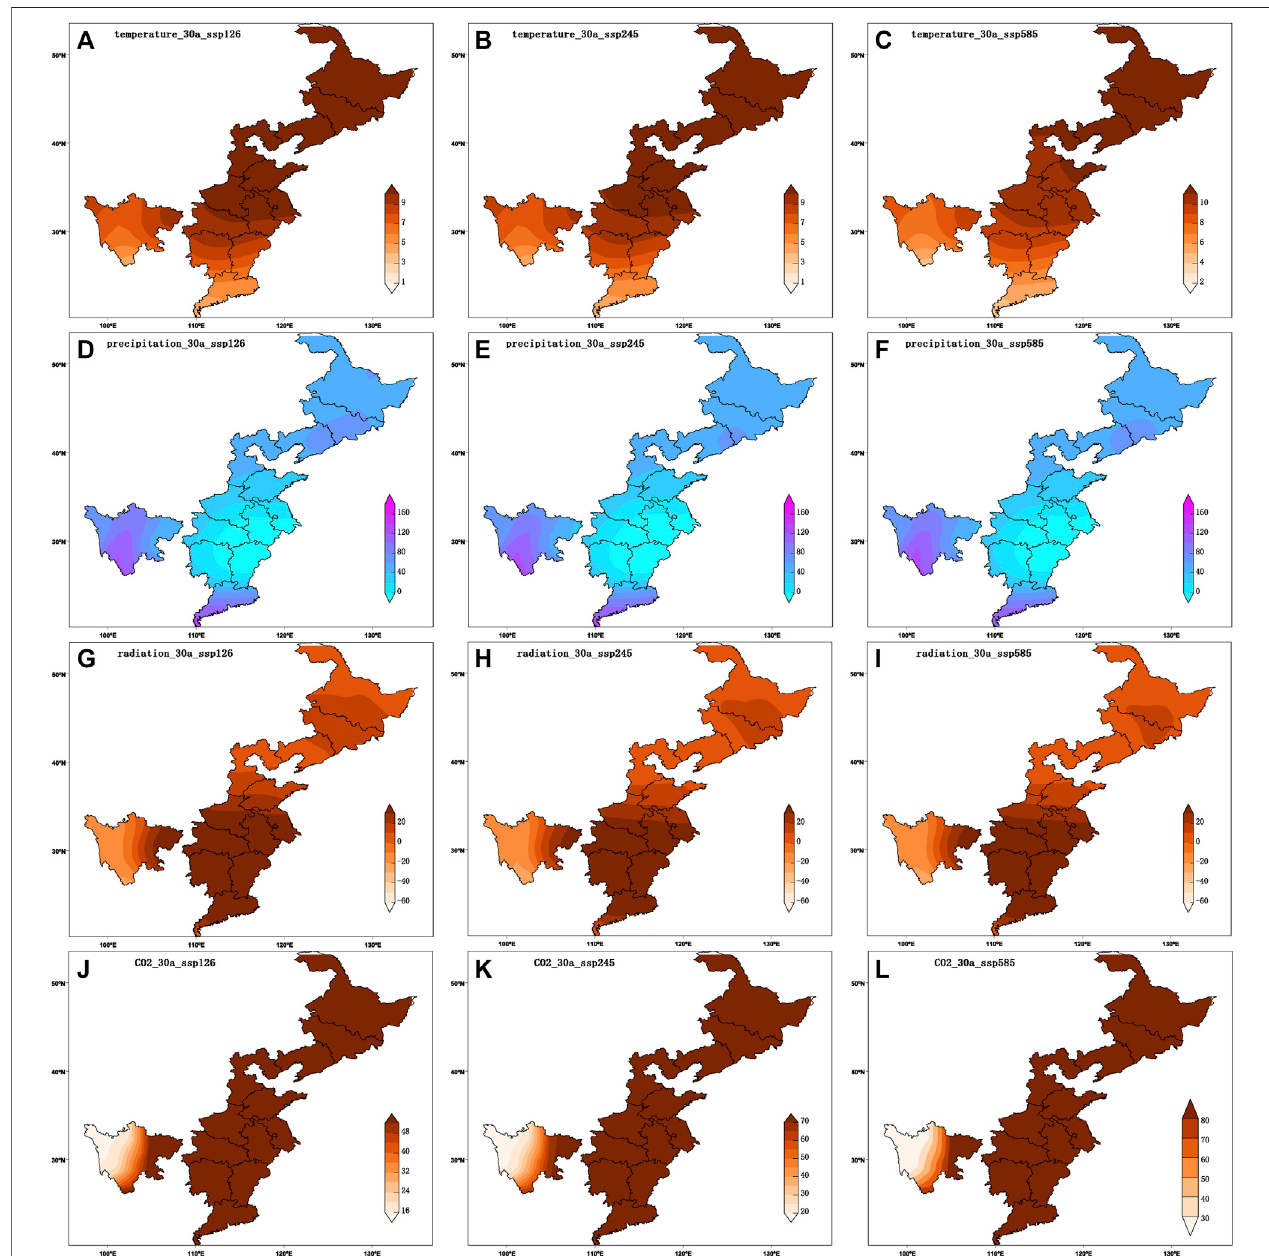
FIGURE 7 | Distribution of changes in climatic factors in China ’ s main grain-producing areas in the next 30 years (2021 – 2050) under three future scenarios. (A, B, C) are the spatial distribution of mean temperature in SSP1-2.6, SSP2-4.5, and SSP5-8.5 scenarios, respectively. (D, E, F) are the spatial distribution of precipitation in SSP1-2.6, SSP2-4.5 and SSP5-8.5 scenarios, respectively. (G, H, I) are the spatial distribution of radiation in SSP1-2.6, SSP2-4.5 and SSP5-8.5 scenarios, respectively. (J, K, L) are the spatial distribution of CO 2 concentration in SSP1-2.6, SSP2-4.5 and SSP5-8.5 scenarios, respectively. The value in the fi gure is the difference between the mean annual value from 2021 to 2050 and the mean annual value from 1981 to